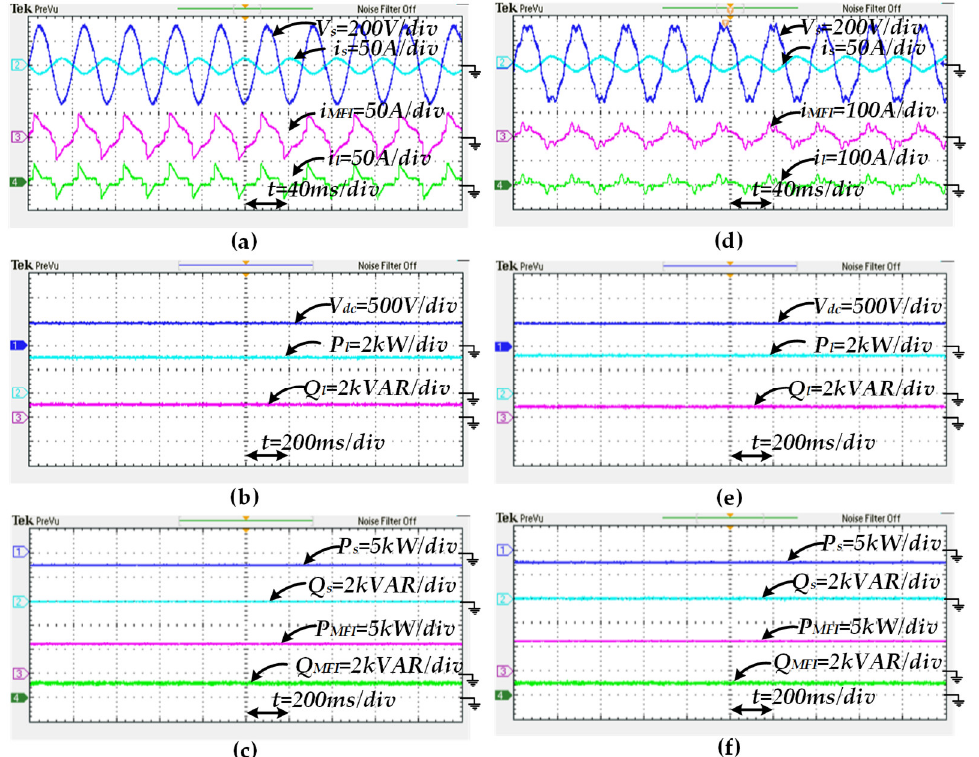
Figure 15. RT SIL test output waveforms under MFI ON, with grid feeding and power conditioning mode; ( a ) ideal grid input voltage, current, MFI current, and load current; ( b ) MFI DC-link voltage, solar irradiation, and PV power under the ideal grid; ( c ) source active power, reactive power, and MFI active and reactive power under the ideal grid; ( d ) distorted grid input voltage, current, MFI current, and load current; ( e ) MFI DC-link voltage, solar irradiation, and PV power under the distorted grid; ( f ) source active power, reactive power, and MFI active and reactive power under the distorted grid.